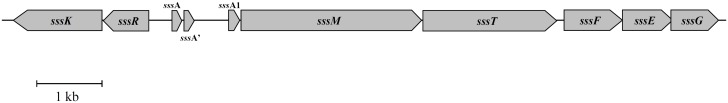
Genetic organization of the putative suicin 65 gene cluster.